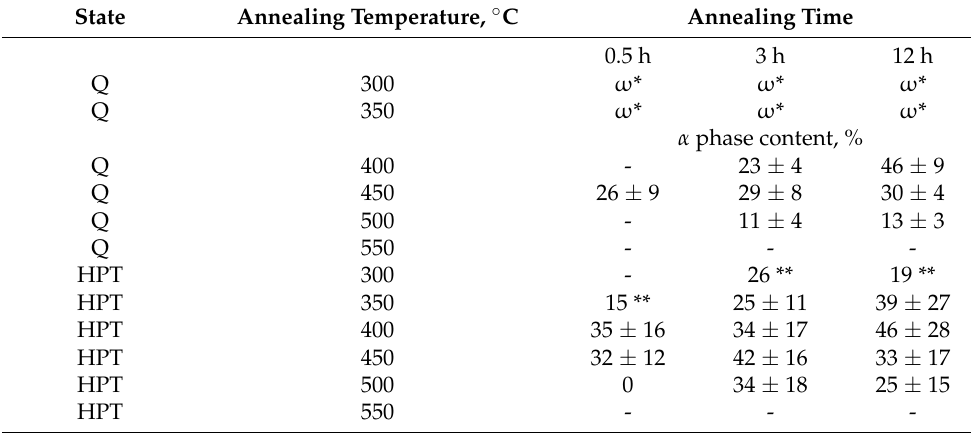
Table 2. Phase analysis results based on the XRD data for the Ti-18Zr-15Nb alloy after Q, HPT and aging during 0.5 h, 3 h, and 12 h at temperatures of 300–550 ◦ C. State Annealing Temperature, ◦